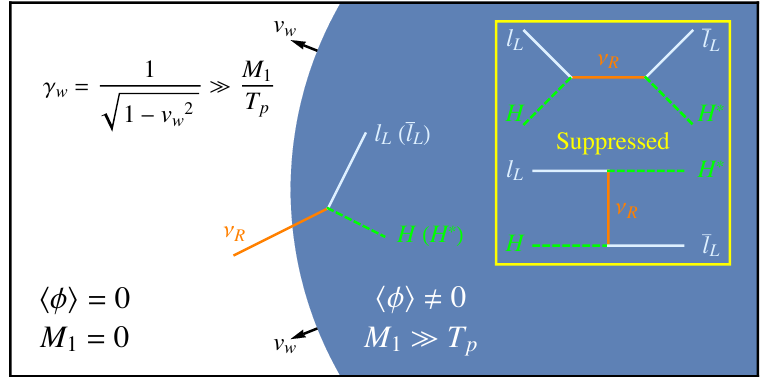
Figure 1 . The sketch of leptogenesis triggered by a FOPT. The blue and white regions represent the new vacuum bubble (in which h φ i 6 = 0 ) and the old vacuum background (in which h φ i = 0 ), respectively. The FOPT occurs at temperature T p , and the bubble expands at a wall velocity v w . Inside a bubble, ν R gains a huge mass M 1 (cid:29) T p , such that the ν R ’s that have penetrated the bubble decay quickly, generating the BAU. The possible washout effects (some of which are illustrated inside the yellow rectangle) are suppressed since M 1 /T p (cid:29) 1